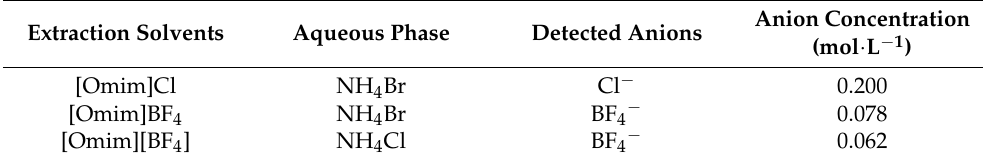
Table 4. Experimental results of the counterevidence